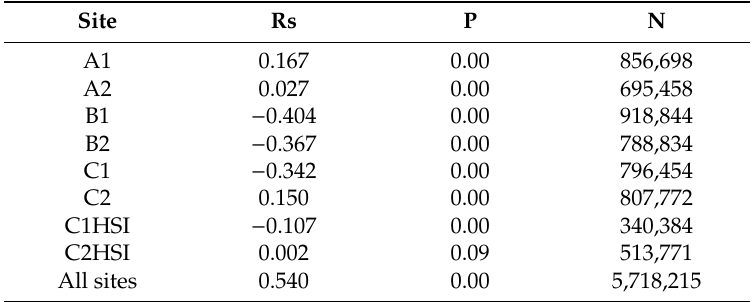
Table 2. The Spearman's rank correlation coefficient Rs between the temperature and NDVI at all the sites. N: Number of the points.